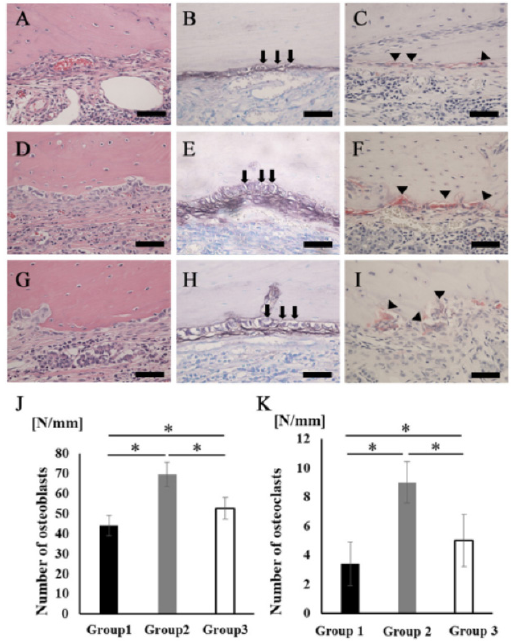
Figure 6. Osteoblasts and osteoclasts in new bone tissue. ( A – C ) Group 1. ( D – F ) Group 2. ( G – I ) Group 3 ( A , D , G ) Newly formed bone area stained with H&E at higher magnification. Scale bars represent 50 μ m. ( B , E , H ) The images of the area equivalent to ( A ), ( D ), and ( G ) stained with ALP. Scale bars represent 50 μ m. The arrows indicate osteoblasts. ( C , F , I ) The images of the area equivalent to ( A ), ( D ), and ( G ) stained with TRAP. Scale bars represent 50 μ m. The arrowheads indicate osteoclasts. ( J ) The number of osteoblasts in the newly formed bone area. ( K ) The number of osteoclasts in the newly formed bone area. * p < 0.05. The results are shown as means, with error bars representing the standard deviation ( n = 15).